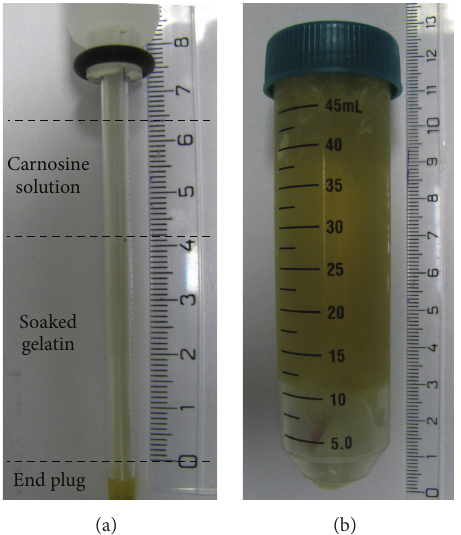
Figure 2: The sample for high resolution NMR: gelatin contained in the stretched silicon tube inside of the NMR tube. Dashed lines indicate interfaces boundaries of gelatin sample (a). The phantom prepared for RDC measurements in a MR tomograph